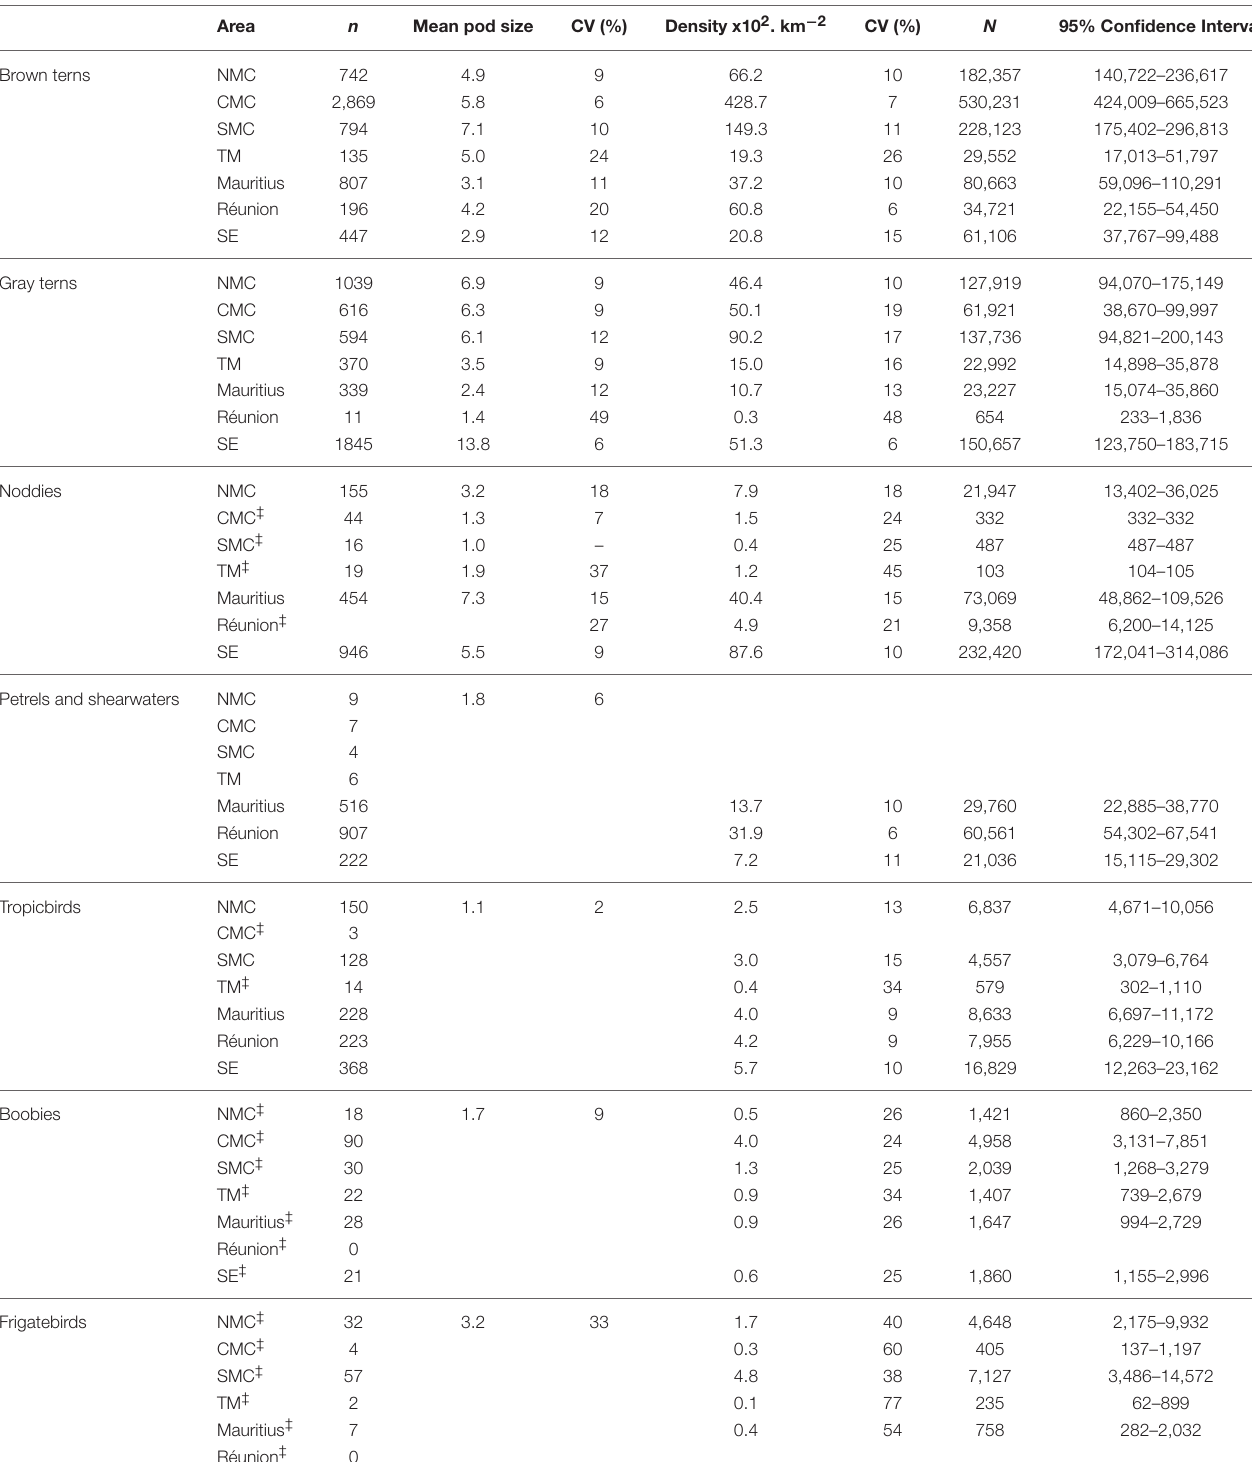
TABLE 4 | Results obtained for seabirds: sightings number ( n , within the strip of 200 m), mean pod size, densities and relative abundance ( N ) estimated per taxonomic group, and survey blocks. Area n Mean pod size Brown